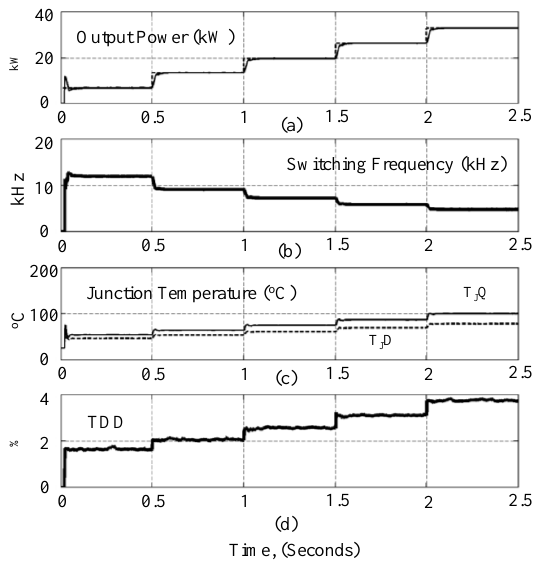
Figure 4. Effect of the load change on the switching frequency, junction temperatures, and TDD, ( a ) the output power in kW; ( b ) the switching frequency in kHz; ( c ) the IGBT and diode junction temperatures in °C; ( d ) the TDD of the output current.